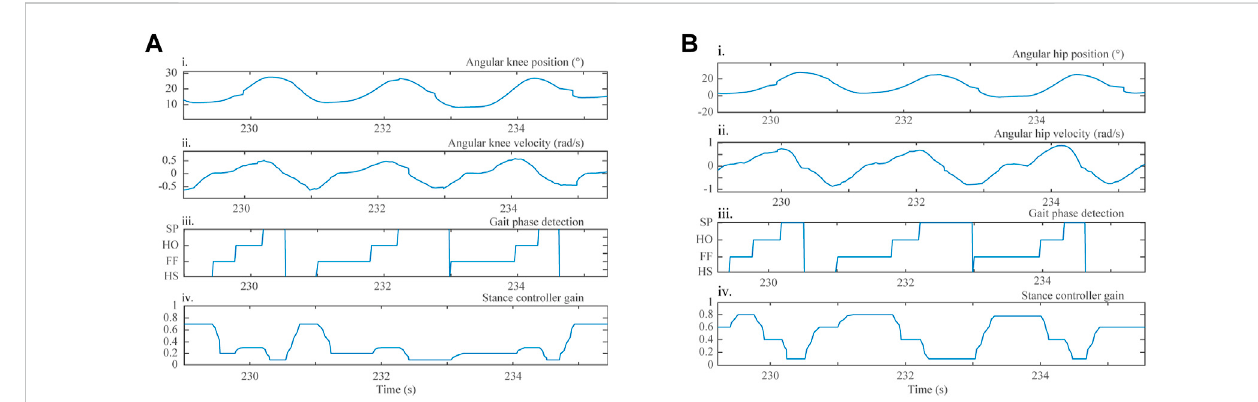
FIGURE 10 Threegaitcycles ofahealthysubjectduringa6-min treadmillwalking test,intermsofthefollowingparameters:(i)angular jointposition; (ii)angular joint velocity acquired with the AGoRA exoskeleton incremental encoders; (iii) gait phase detection outcome, determined using the gait phase detection module; and (iv) modulation method response, for the (A) knee and (B) hip